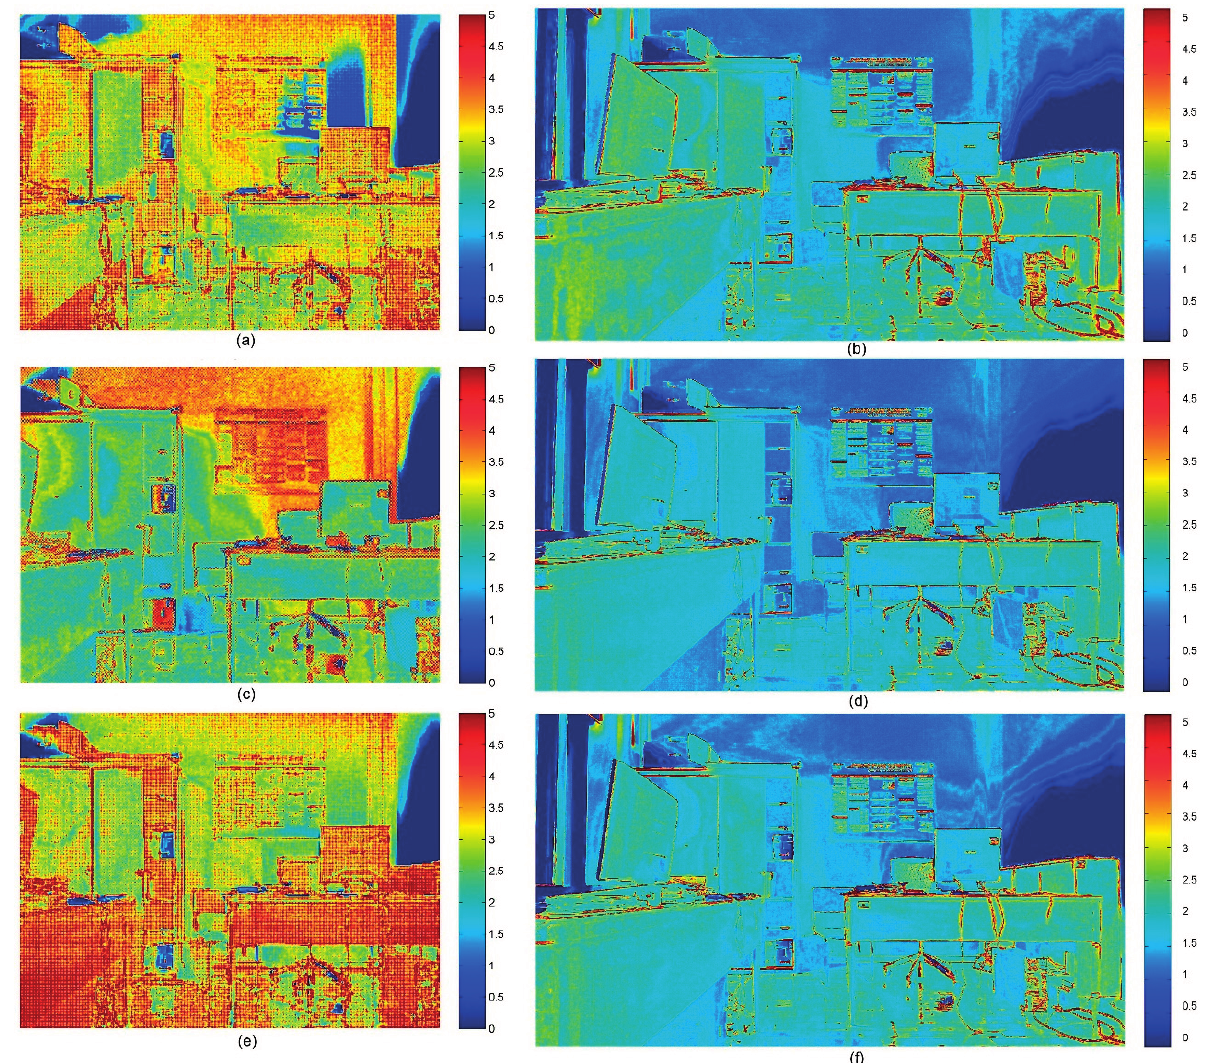
Figure 3. Standard deviation (st.dev.) computed on 100 subsequent frames acquired with Kinect 1.0 (left) and Kinect 2.0 (right) for each corresponding pixel for each channel. ( a ) Kinect 1.0 st.dev.: red channel; ( b ) Kinect 2.0 st.dev.: red channel; ( c ) Kinect 1.0 st.dev.: green channel; ( d ) Kinect 2.0 st.dev.: green channel; ( e ) Kinect 1.0 st.dev.: blue channel; and ( f ) Kinect 2.0 st.dev.: blue